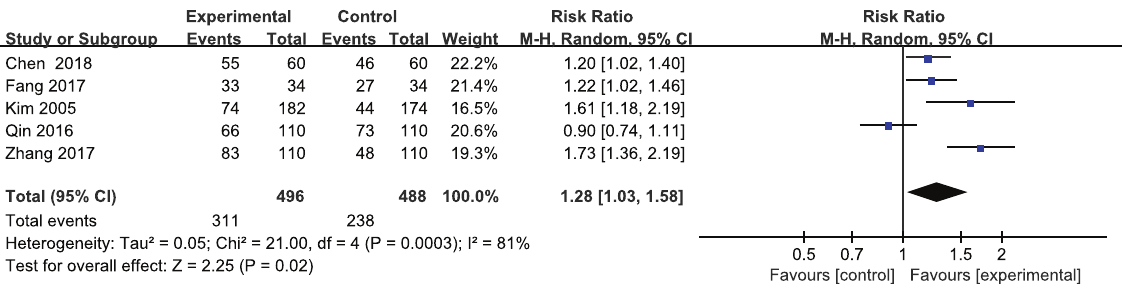
Figure 4. The rate of adequate bowel